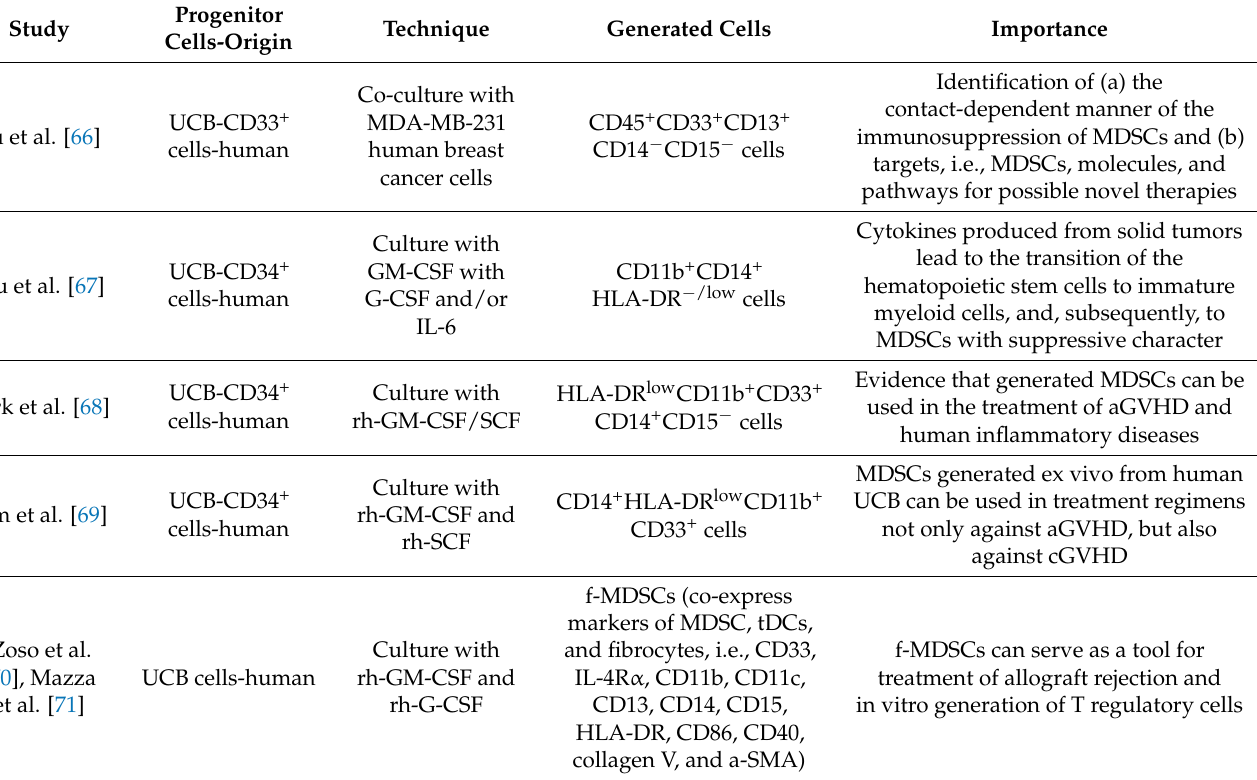
Table 1. Studies involving in vitro and ex vivo expansion of